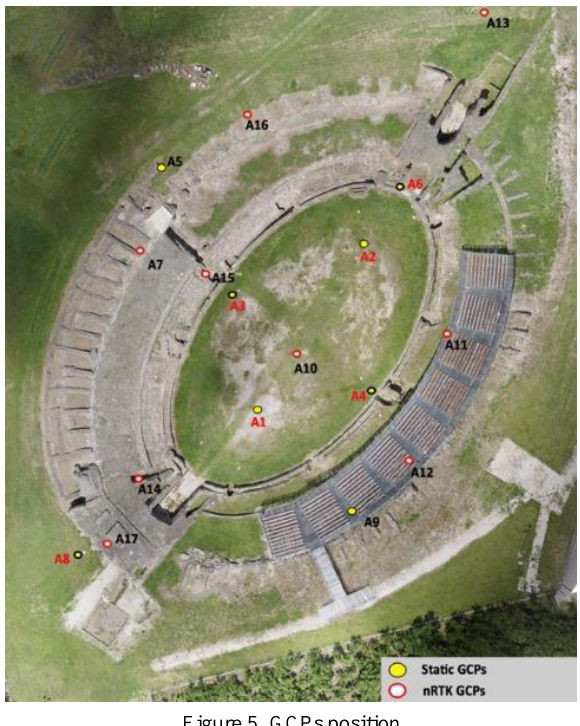
Figure 5. GCPs position